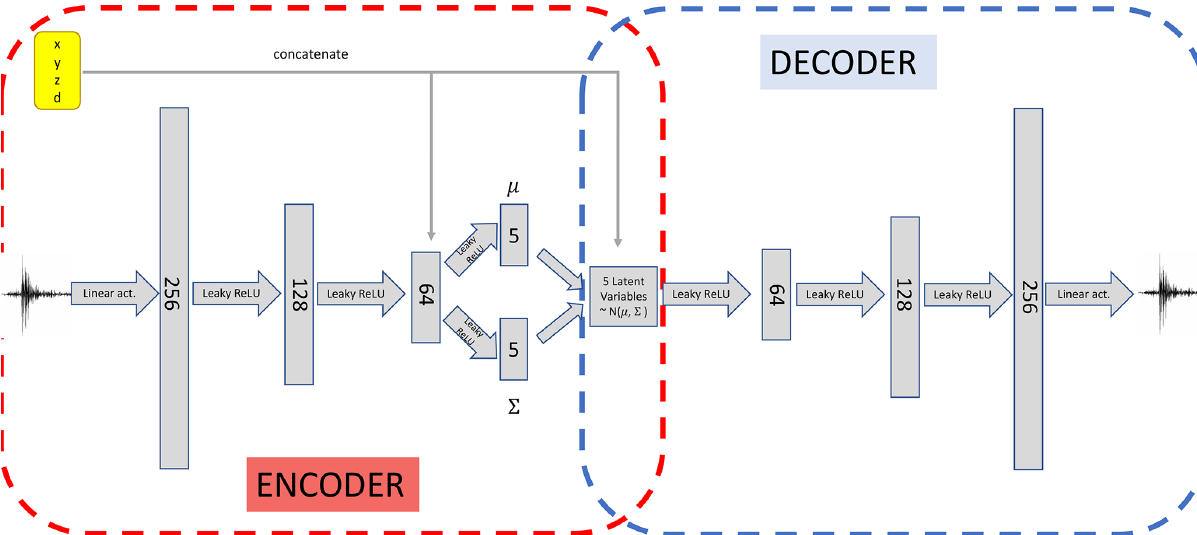
Figure 5. Schematic of the architecture of the conditional variational autoencoder used in this work. A “funnel-like” structure analogous to the simple autoencoder described in Fig. 4 is used, with the central features being sampled from multivariate Gaussian distributions N (µ, (cid:54) ) with mean µ and covariance (cid:54) , as described in Sect. 2.2.6, after concatenating the coordinates (x,y,z,d) to the last layer of the encoder (circled in red). The concatenation is repeated in the latent space represented by the multivariate Gaussian distributed encoded features. In a similar fashion to the simple autoencoder case, the decoder part (in blue) of the conditional variational autoencoder can be used as a generative model, after training the full network to reproduce the input seismograms in